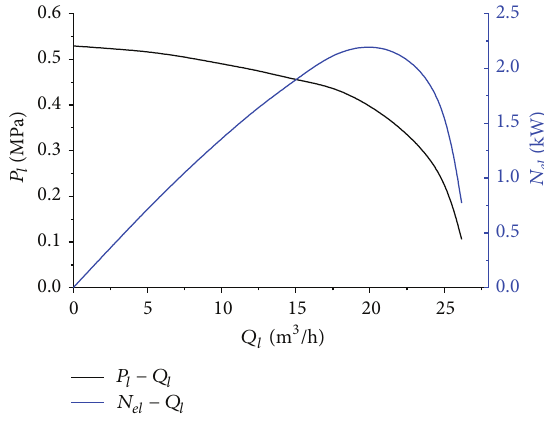
Figure 3: Performance curve of centrifugal pump.